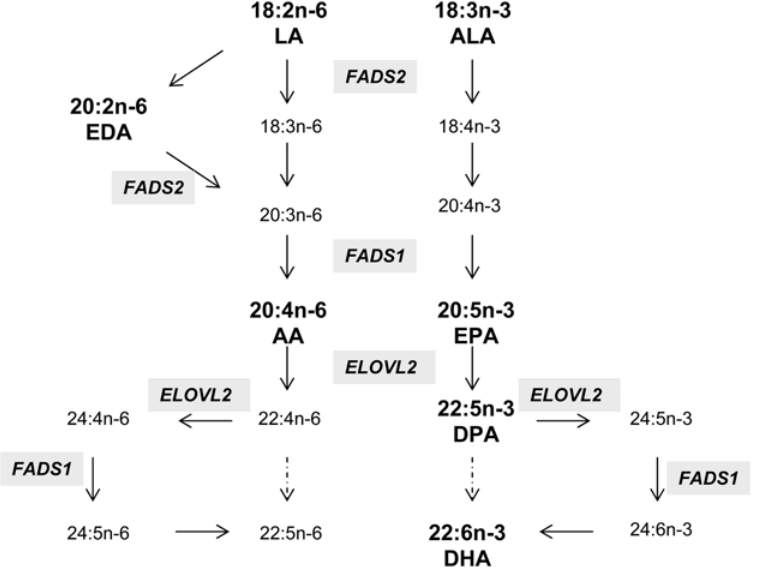
Figure 1. The metabolic pathway of n-3 and n-6 fatty acids. The fatty acids examined in the study are indicated in bold. The dashed arrows indicate pathways absent in mammals.